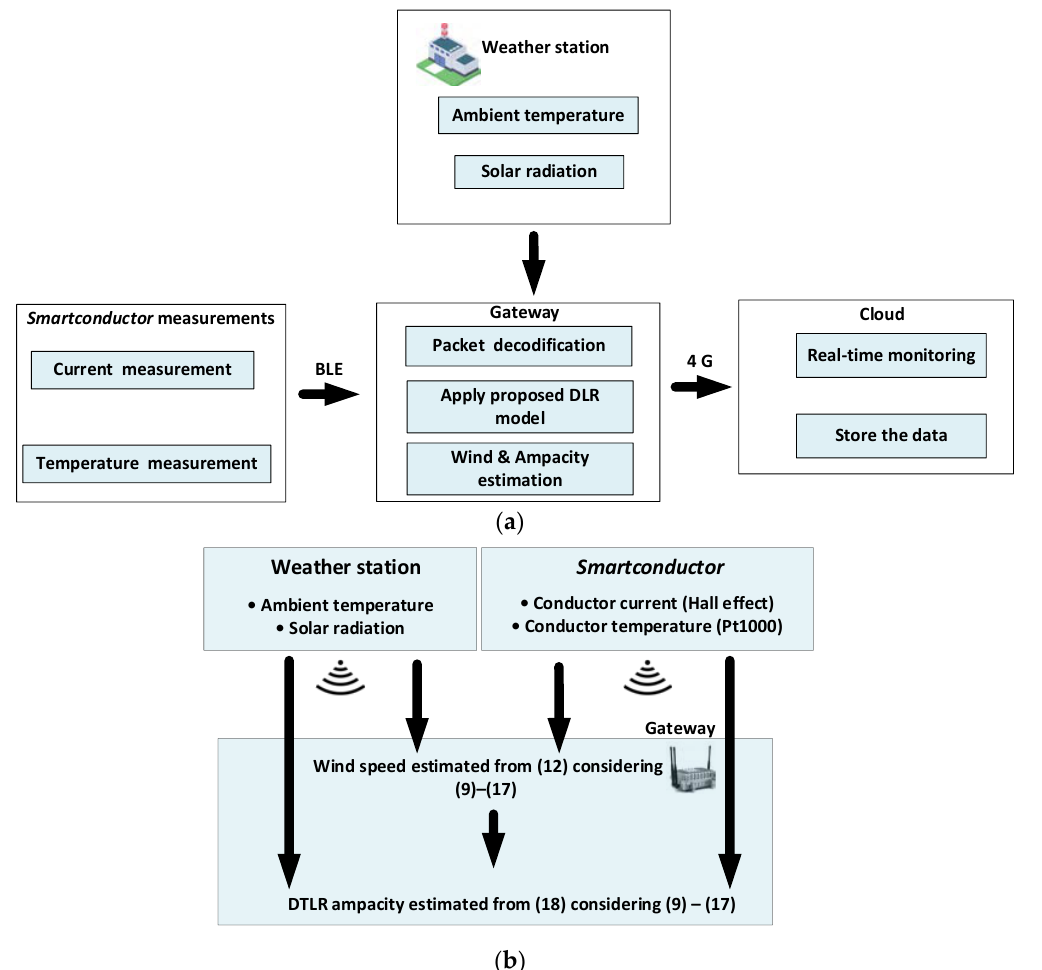
Figure 1. Proposed strategy to estimate the ampacity. ( a ) Global strategy. ( b ) Block diagram of the strategy to determine the DTLR rating.